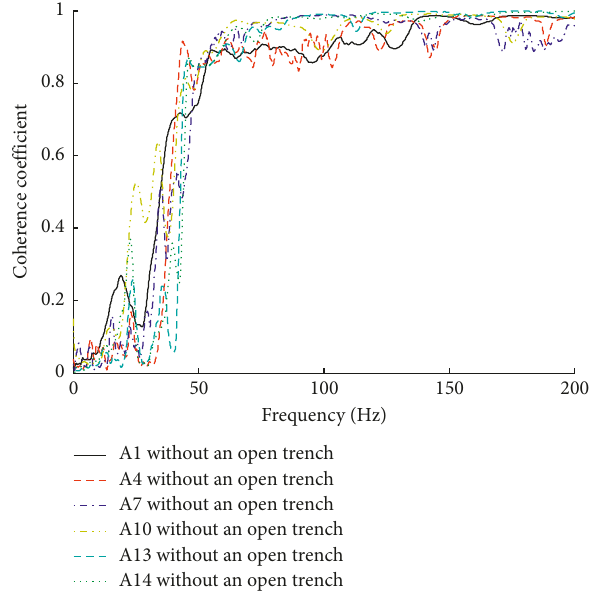
Figure 7: Coherence coefficient at points A1, A4, A7, A10, A13, and A14.